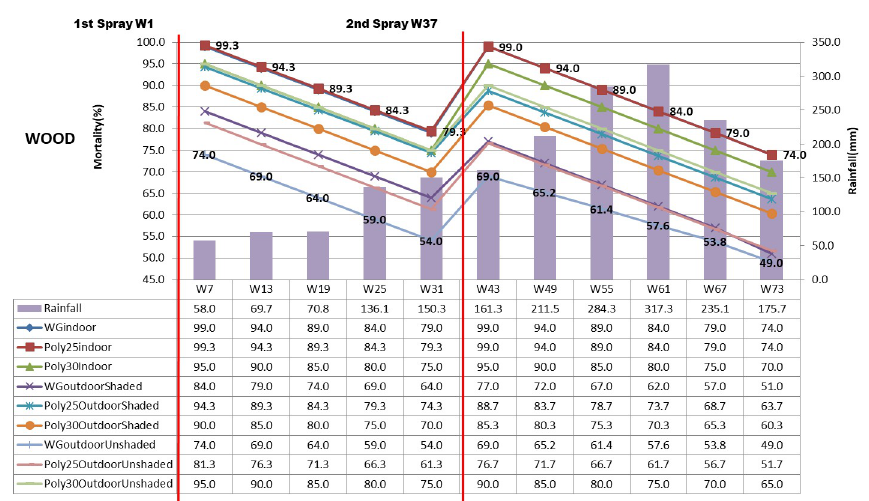
Fig 3. Mortality rate (%) based on location, insecticide, wood wall and rainfall.